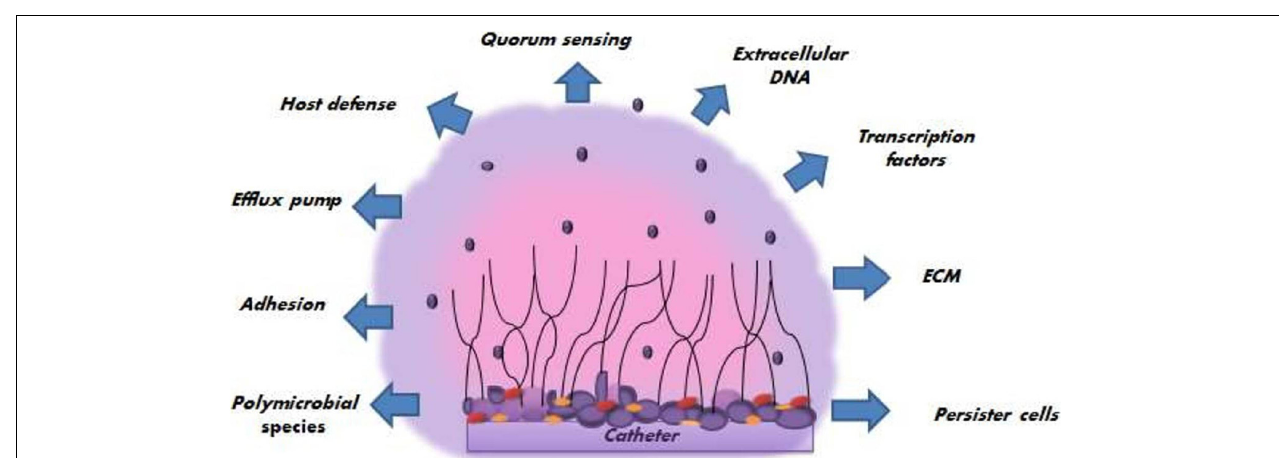
FIGURE 3 | Different factors promoting the pathogenesis of the C. albicans